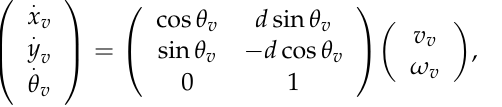
between the ideal state of the follower robot and the leader robot in the coordinate system of the leader robot. l d is the distance between the ideal state of the follower robot and the iL leader robot. The leader formation control algorithm can be introduced virtual leader robots as expectation analysis. In a nonholonomic system, both the virtual leader robot and the navigation robot meet the nonholonomic constraints. The mathematical model of the virtual leader robot can be described as Equation (21).